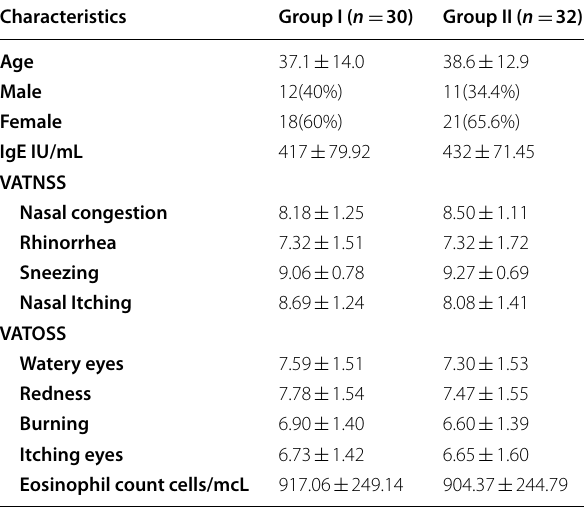
Table 1 Baseline clinical characteristics of patients with